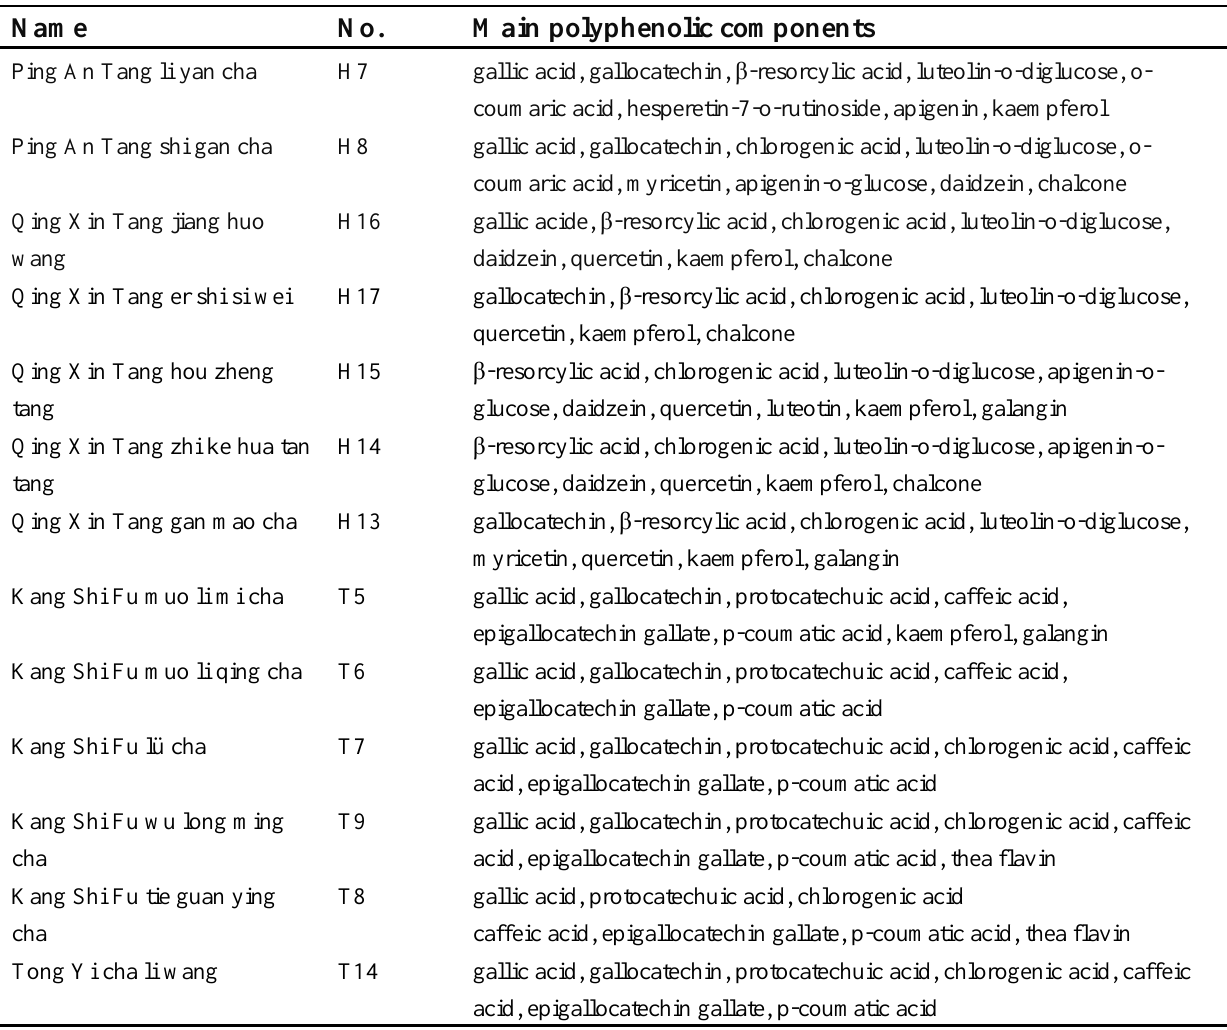
Table 3. Main polyphenolic components in herbal and tea infusions showing the highest phenolic contents and antioxidant